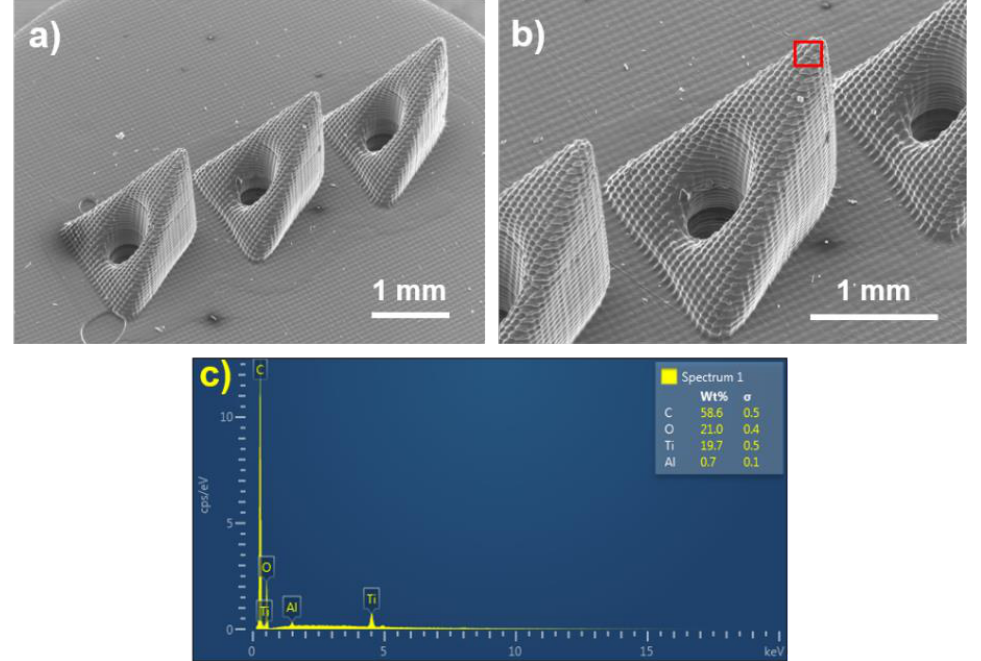
Figure 2 . ( a ) Low-magnification SEM image of the microneedle array, showing all three tips, ( b ) high-magnification image of a single microneedle within the array, and ( c ) EDS data from the mi- croneedle tip (red rectangular region) in ( b